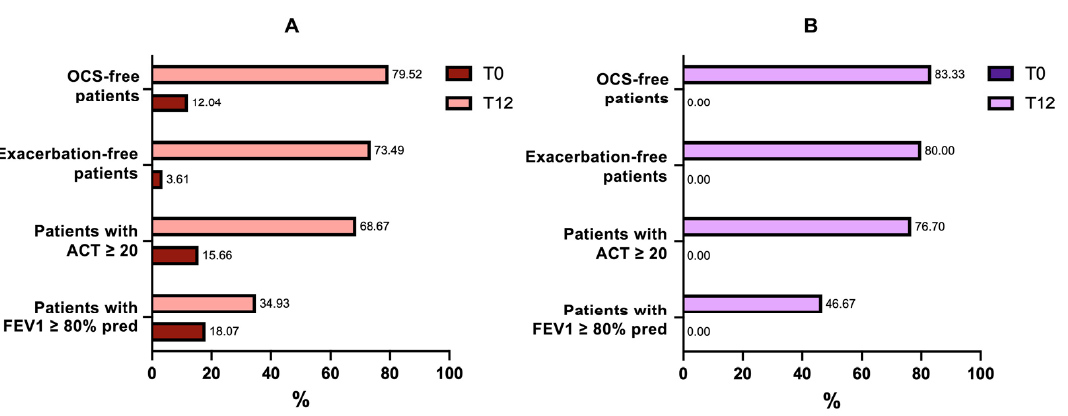
Figure 5. Percentage of mepolizumab-treated ( panel A ) and benralizumab-treated ( panel B ) patients meeting individual criteria for clinical remission in asthma.